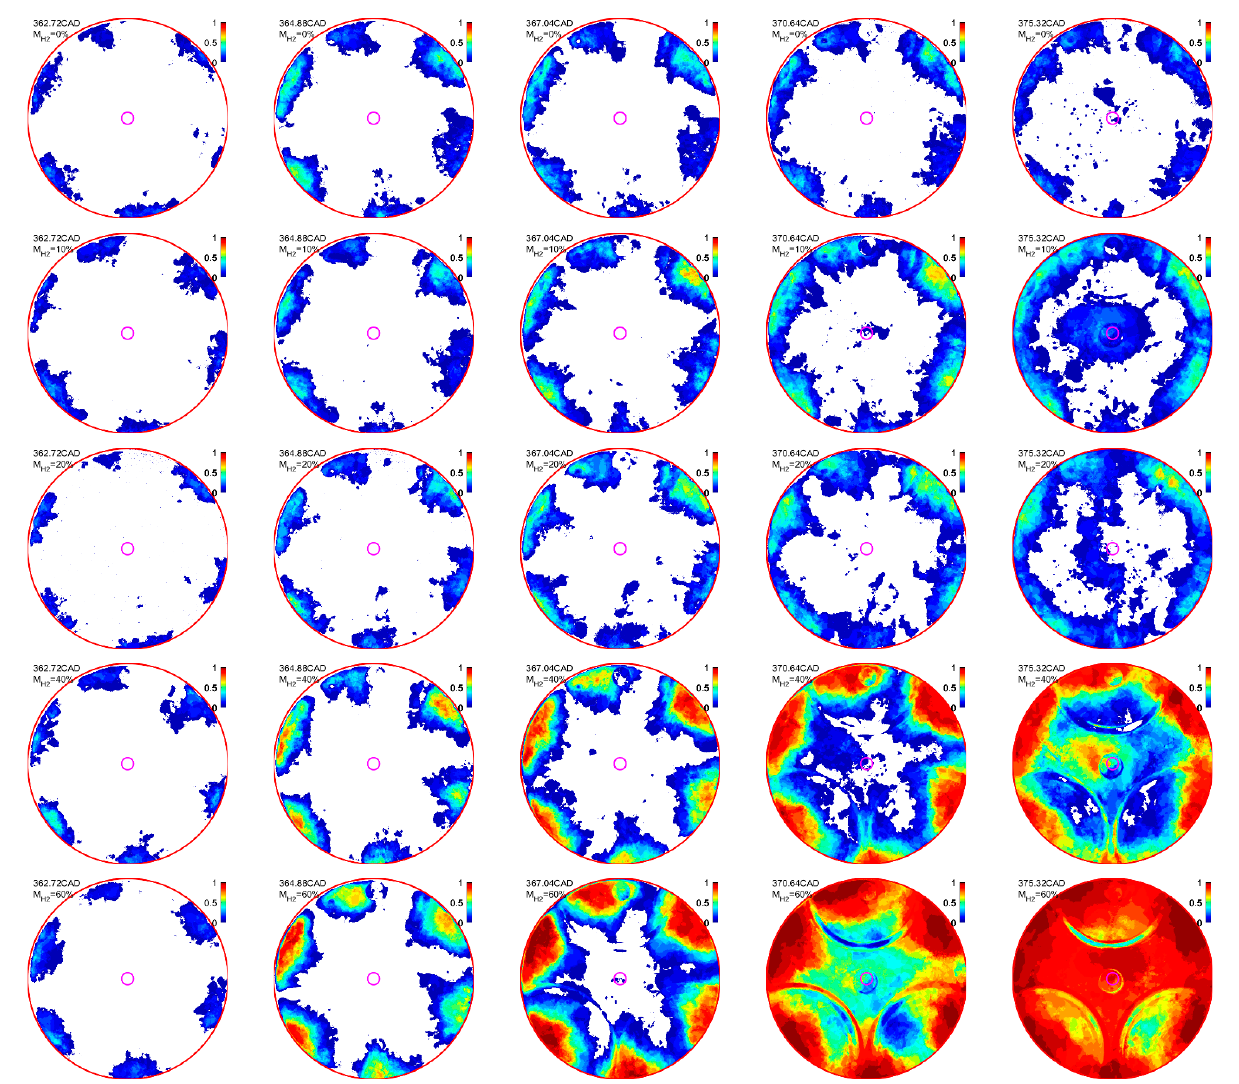
Figure 9. Probability of flame distribution index of NFL images at different crank angles. All five test cases from 𝜒 (cid:3009)(cid:2870) / (cid:3004)(cid:3009)(cid:2872) = 0 to 60% (row 1 to row 5) at various crank angles (column 1 to 5) are summarized to characterize the FSI. The color contour from blue to red represents the FSI from 0 to 1. (The pink circle is the edge of the combustion bowl).